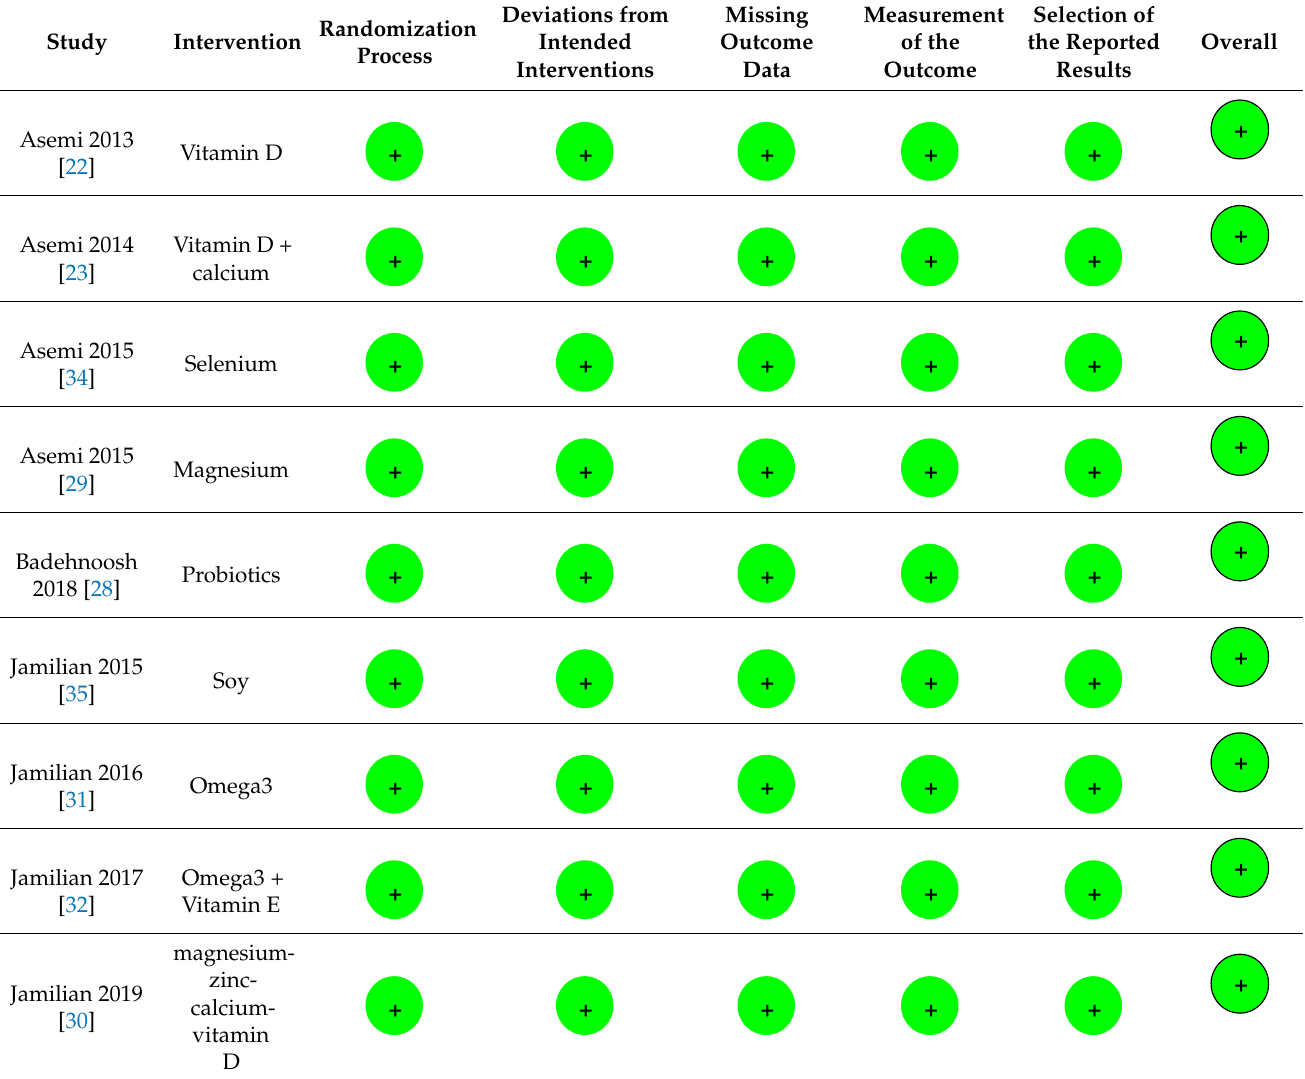
Table 2. Risk of bias of selected studies.